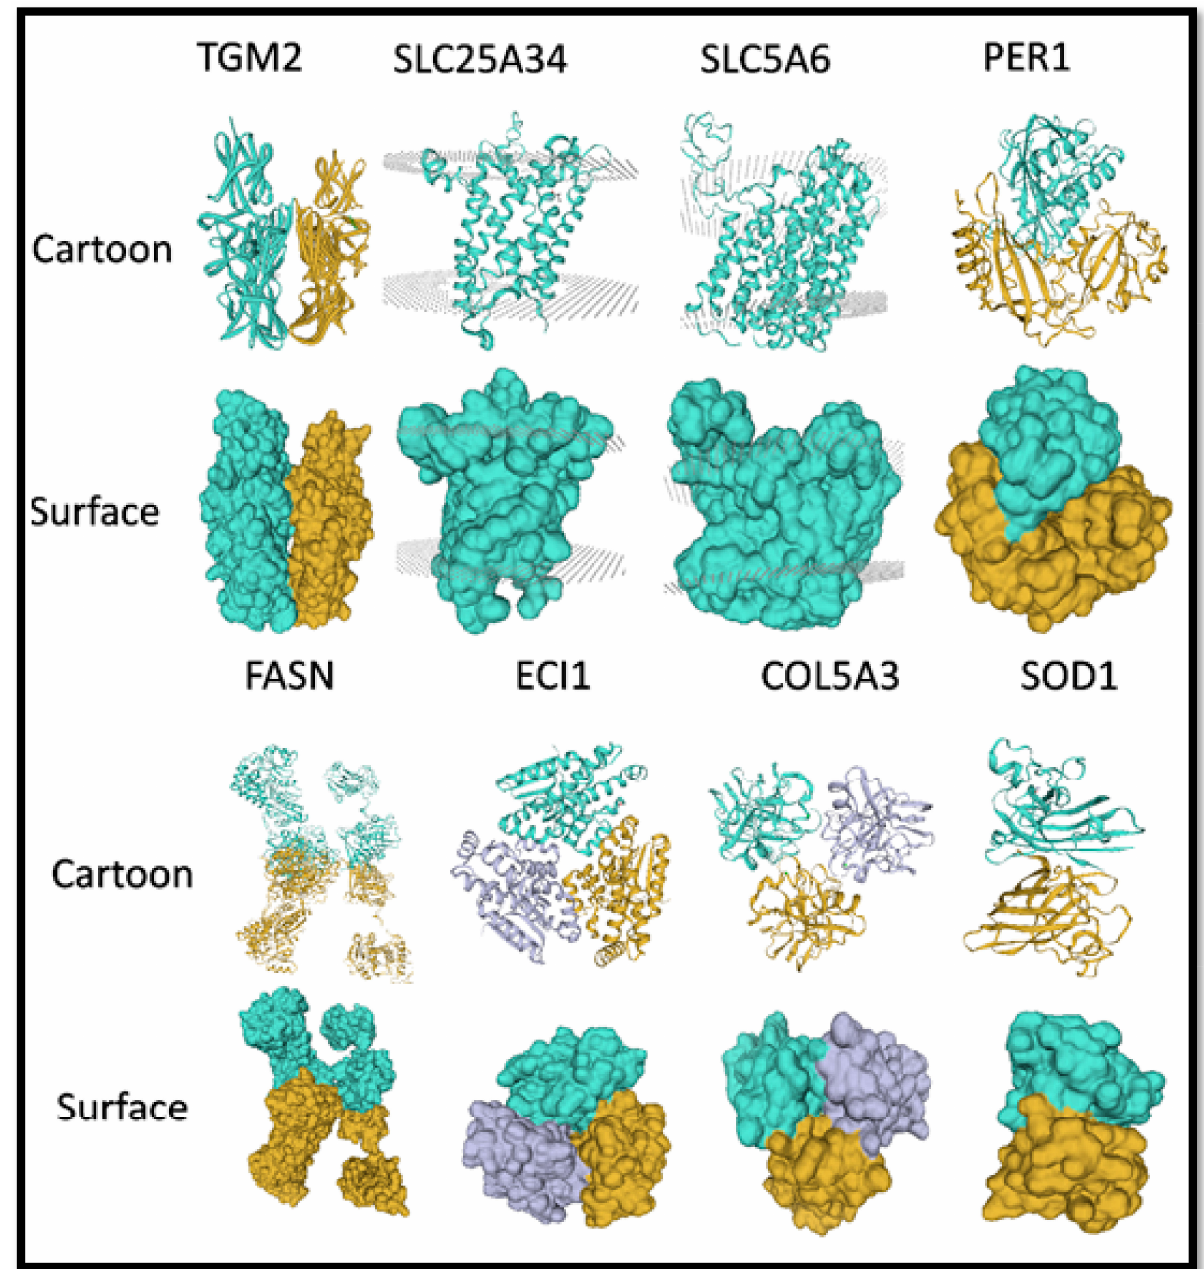
Figure 10. A 3D model structures of eight IMF-associated proteins in cartoon and surface orientations. Models were selected on homology bases with at least 40% similarity and a 100% confidence